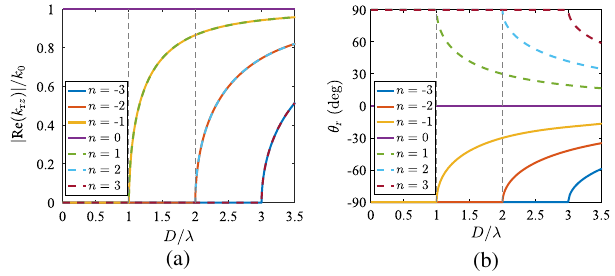
FIG. 2. (a) The real part of the normal wave number for different Floquet harmonics versus the periodicity of the reflector. (b) The reflection angle of the corresponding Floquet harmonics. The incident angle is θ i ¼ 0